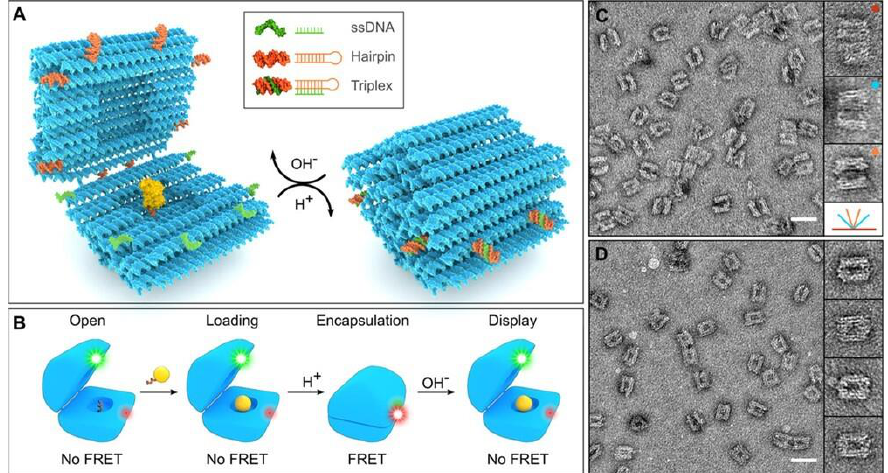
Figure 4. DNA origami capsule. (A) At high pH the nanocapsule is at an open state while upon pH drop the locks (hairpin in orange and ss DNA in green) establish a triplex DNA motive that holds the capsule halves together. (B) Depiction of the capsule stages. At the open state the cargo (yellow sphere) can be anchored to the capsule interior. The cargo is encapsulated by dropping the pH and revealed at high pH. The cycle of capsule function can be monitored by introducing a FRET pair (red and green dyes). ( C ) TEM data shows that the open nanocapsules can exhibit a number of opening angles. Representative open structures are shown with their corresponding angles depicted in different colours. ( D) TEM data of the nanocapsules at a close state with zoomed in frames of representative structures. (Scale bar at C and D is 50 nm. Width of the zoomed in images is 60 nm). Reproduced with permission from [150] Copyright American Chemistry Society, 2019